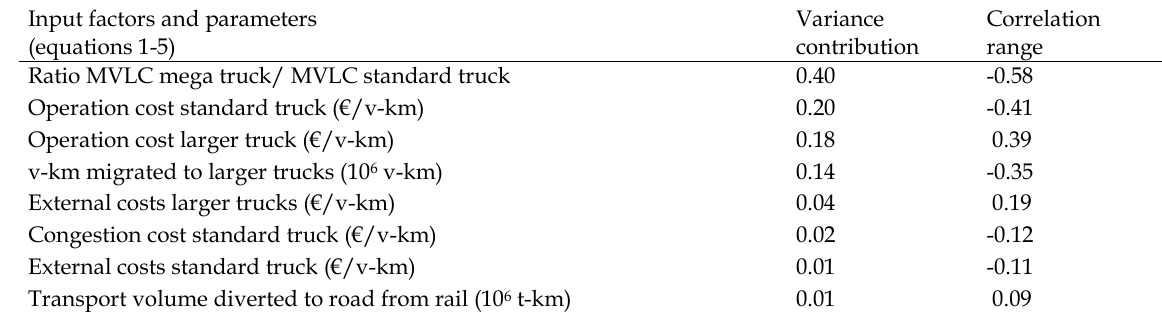
Table 8. Sensitivity analyses for transport cost (M€) regarding parameter changes (equations